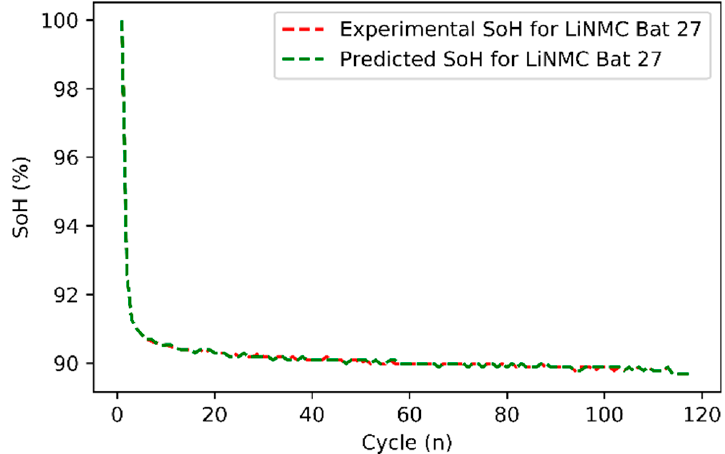
Figure 8. The SOH prediction of battery 27.